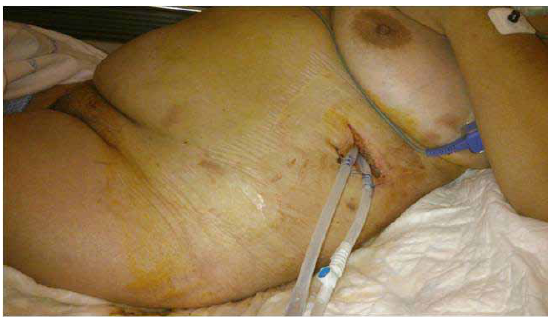
Figure 2. Minimally invasive technique of VARD used in our institution. A system of drains are placed for continuous postoperative